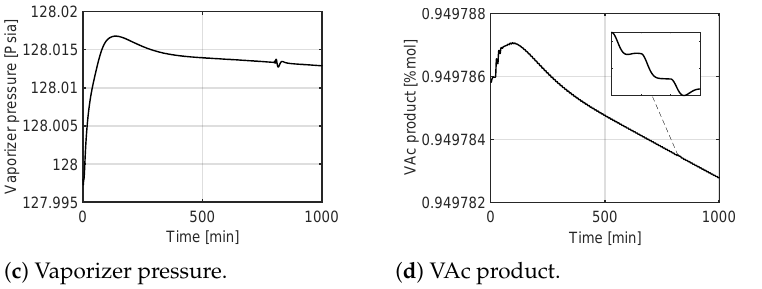
Figure 6. Example intervention on the HAC feed valve (control variable #3), and its impact on a selection of observable variables.